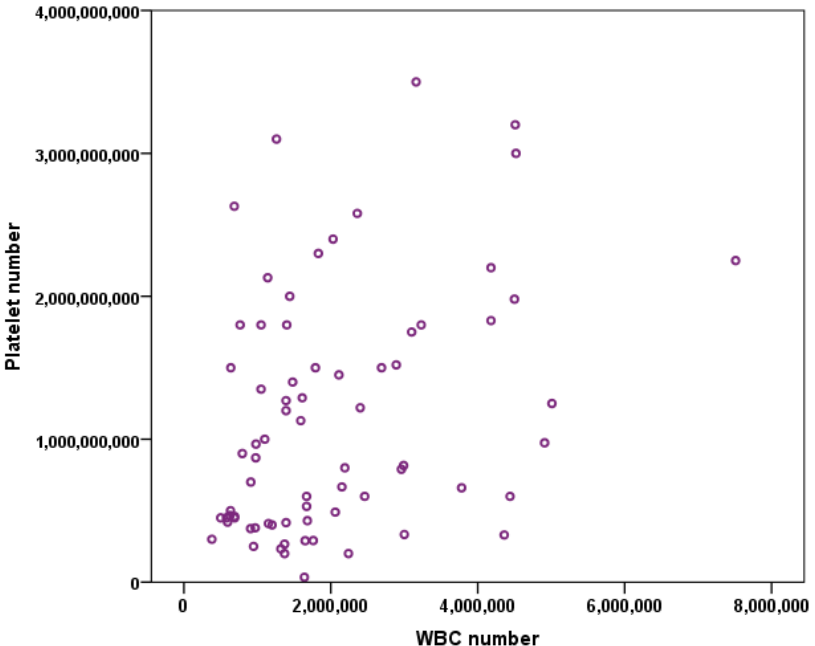
Figure 1. Pearson’s test show a positive correlation ( p = 0.02, r = 0.357) between platelet count and white blood cells (WBC) count across all the dog breed included in our study.